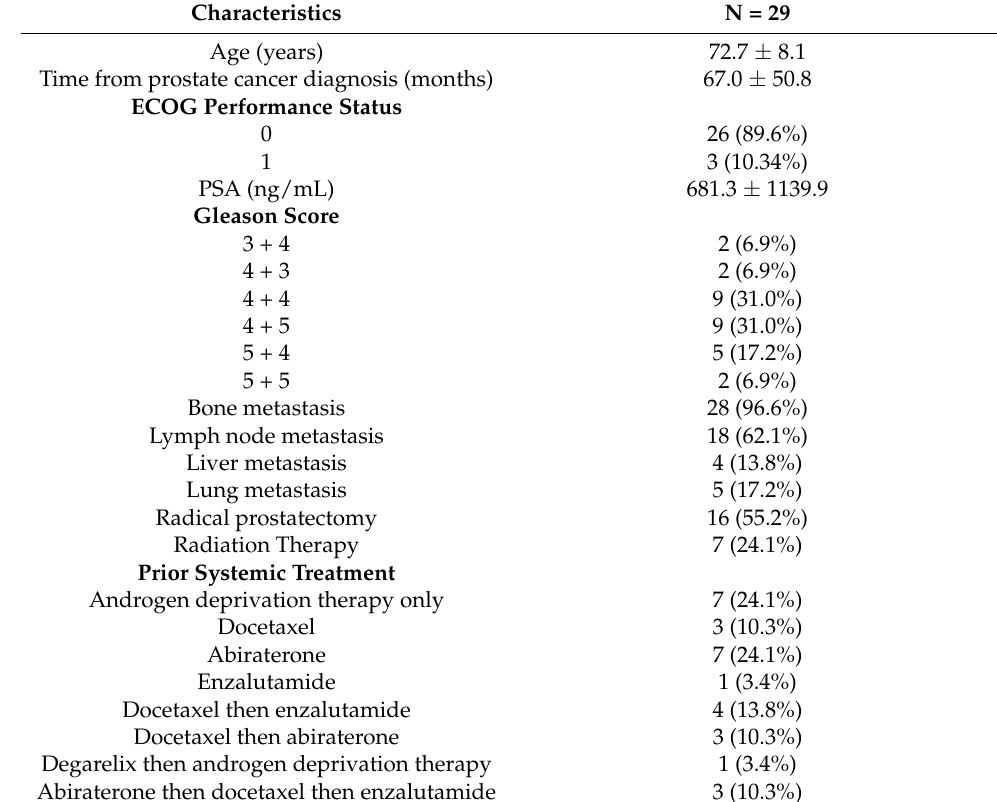
Table 1. Baseline